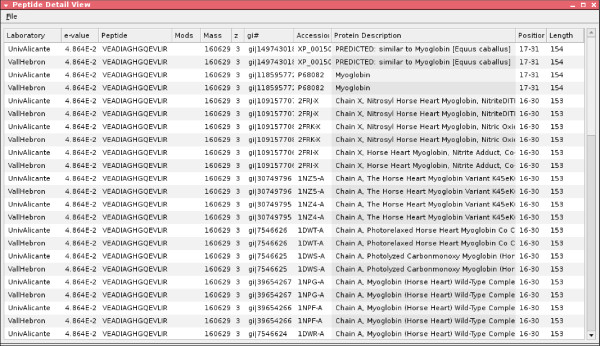
OMSSA peptide detail view.